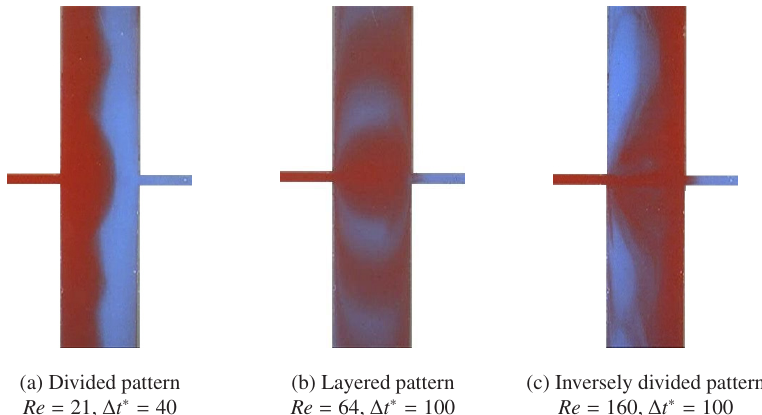
Fig. 6 Visualization results of flow patterns immediately after injection from the left inlet in a cross-shaped channel ( θ = 0, L mix = L in ×